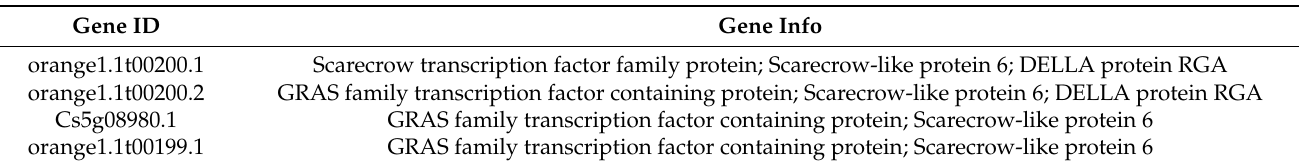
Table 1. The predicted target genes of miR171b.